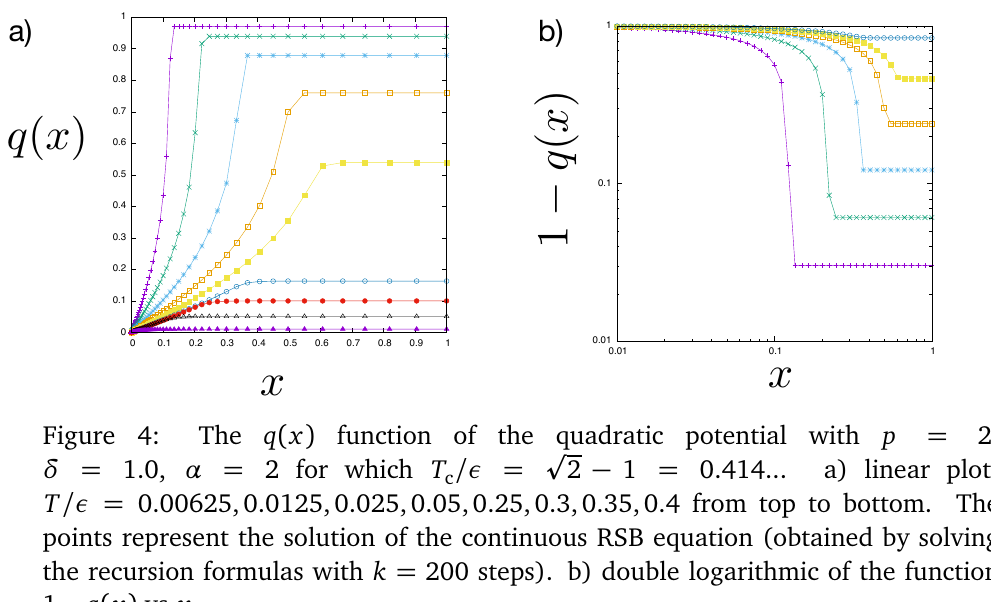
Figure 4: The q ( x ) function of the quadratic potential with p = 2, (cid:112) δ = 1.0, α = 2 for which T /ε = 2 − 1 = 0.414... a) linear plot: c T /ε = 0.00625,0.0125,0.025,0.05,0.25,0.3,0.35,0.4 from top to bottom. The points represent the solution of the continuous RSB equation (obtained by solving the recursion formulas with k = 200 steps). b) double logarithmic of the function 1 − q ( x ) vs x